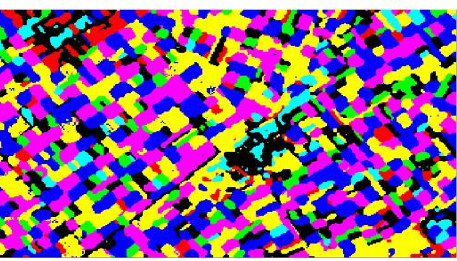
Figure 6. Classified image generated by SVM-MRF, where C=10, σ=1, λ=0.95 and T=0.02